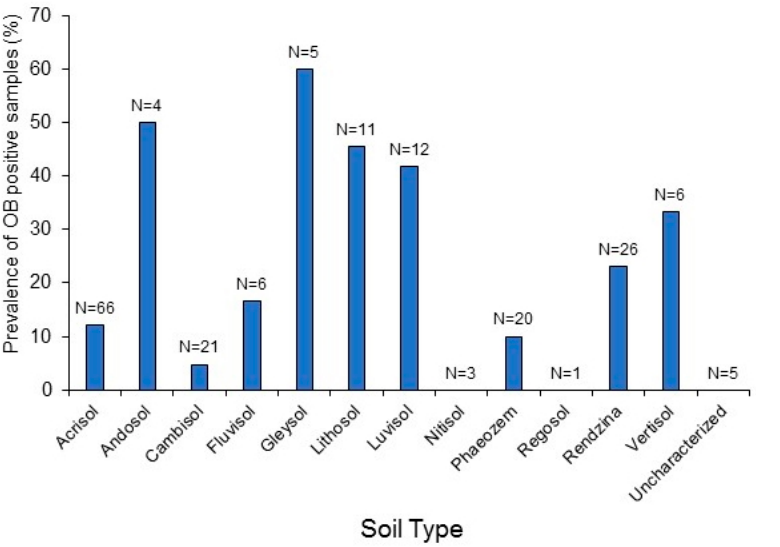
Figure 5. Prevalence of samples from different types of soil that were positive for SfMNPV OBs. Values above columns indicate the number of samples tested (N).